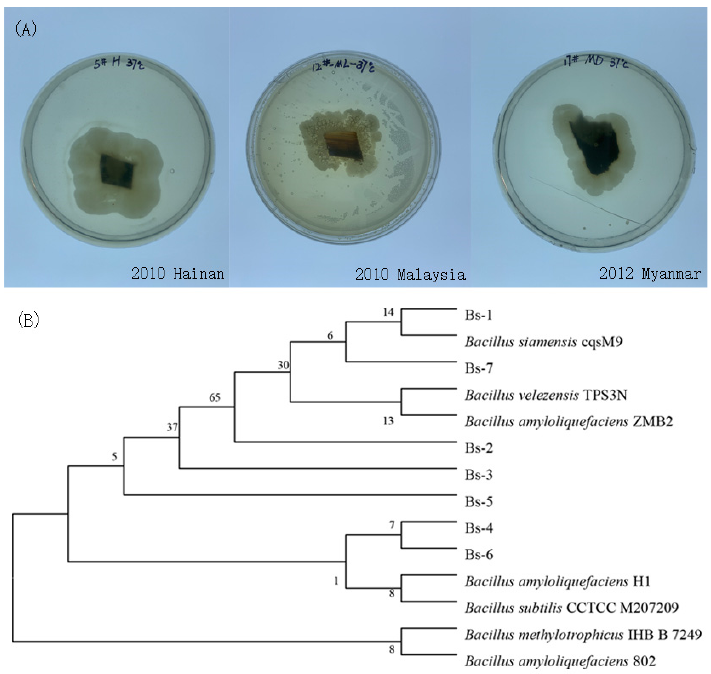
Figure 1. Isolation and identification of Agarwood saprophytic bacteria. ( A ): 10-year-old Agarwood from different places was washed by ethanol followed by drying in a clean biosafety hood. Then a small piece was cut from the center of each sample and cultivated in a PDA medium. Strains grown around the small slides indicated they were saprophytic microorganisms. ( B ): Phylogenetic tree constructed based on the alignment of 16S rDNA